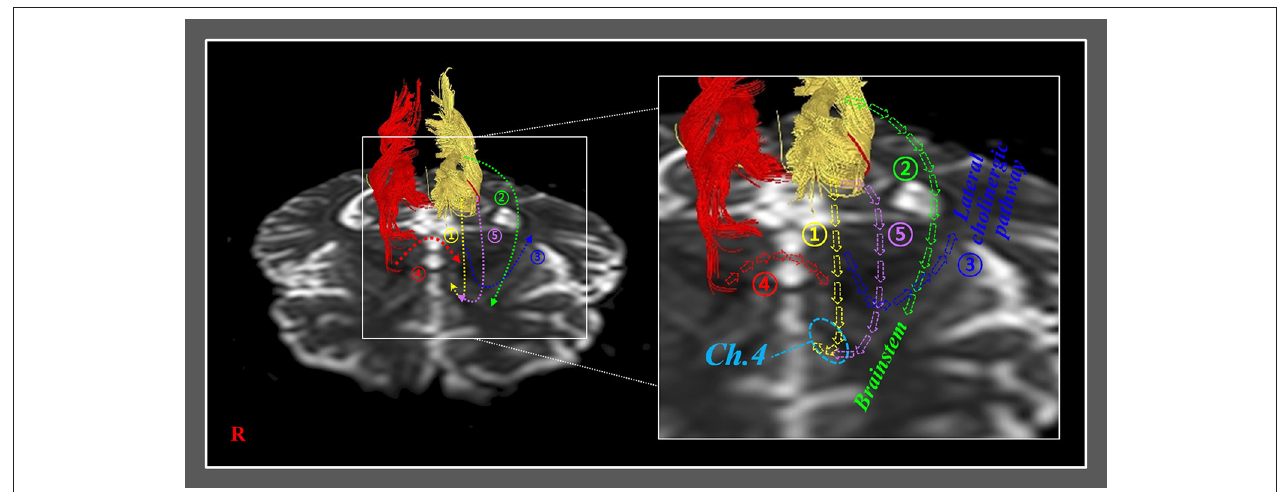
FIGURE 2 | Previously reported recovery mechanisms associated with injured anterior cinguli. À Mechanism 1: recovery via the normal pathway of the cingulum between an injured cingulum and the basalis nucleus of Meynert (Ch 4). Á Mechanism 2: recovery through a neural tract between an injured cingulum and brainstem cholinergic nuclei. Â Mechanism 3: recovery through a lateral cholinergic pathway between an injured cingulum and the white matter of the temporo-occipital lobes. Ã Mechanism 4: recovery through a neural tract between the contralesional basal forebrain and the ipsilesional basal forebrain via the genu of the corpus callosum. Ä Mechanism 5: recovery through a neural tract between an injured cingulum and Ch 4 via an aberrant